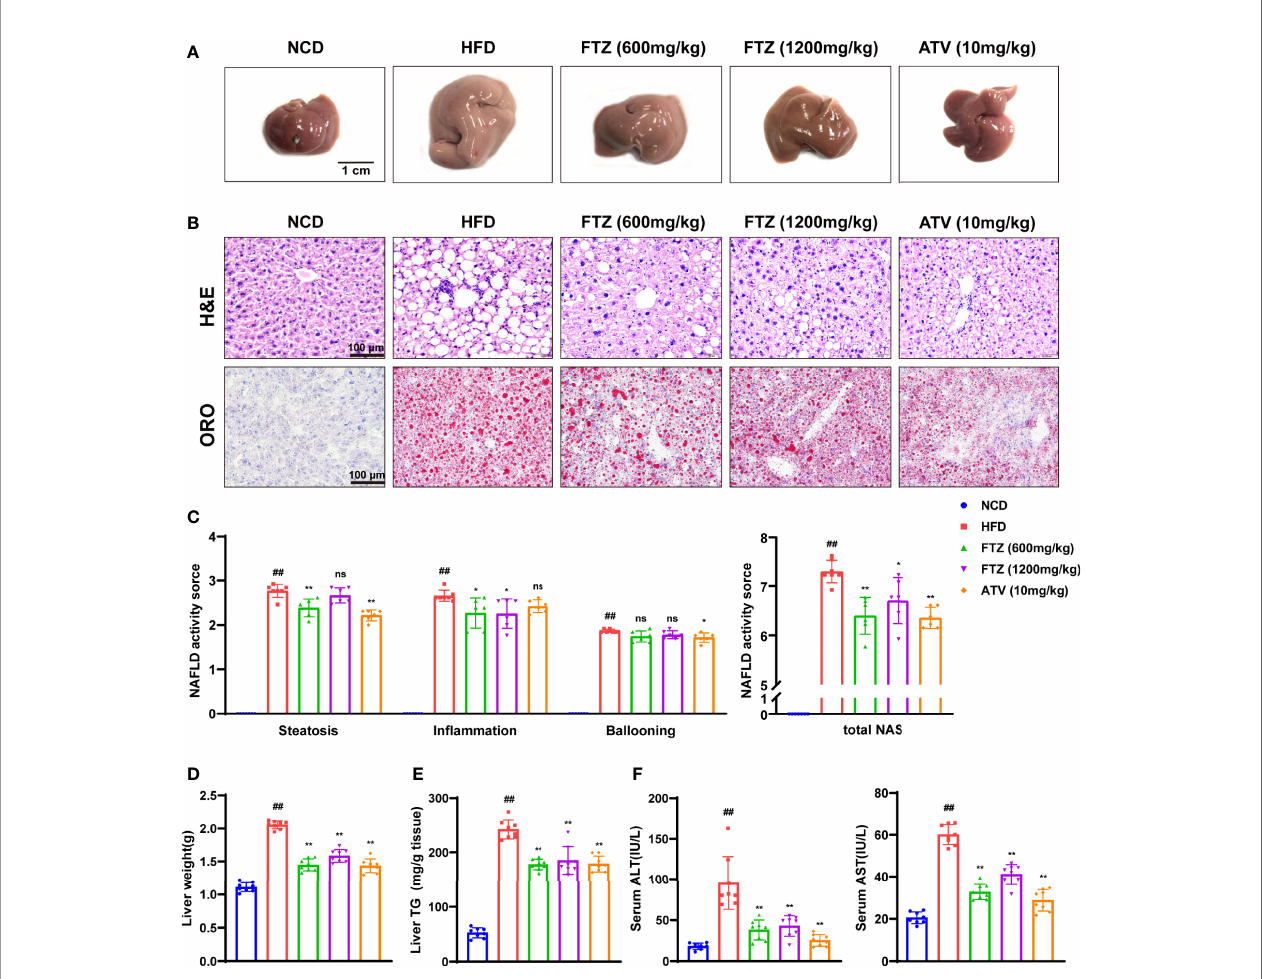
FIGURE 2 | Effects of FTZ on hepatic steatosis and lipotoxicity in mice. (A) Representative macroscopic images of the livers of NCD, HFD, FTZ, and ATV mice. (B) Representative images of H&E and oil red O staining of liver sections. (C) NAS score in the indicated groups (n=6-7). (D) Liver weight (n=8). (E) Liver TG content (n=8). (F) Serum ALT and AST levels of the mice in the indicated groups (n=8). Data are represented as means ± SEM. # indicates a signi fi cant difference between the NCD group and the HFD group (t-test); * indicates a signi fi cant difference between the FTZ (600 mg/kg)/FTZ (1,200 mg/kg)/ATV (10 mg/kg) group and the HFD group (one-way ANOVA). ## P < 0.01 versus NCD mice; * P < 0.05, ** P < 0.01 versus mice fed by HFD. ns indicates no signi fi